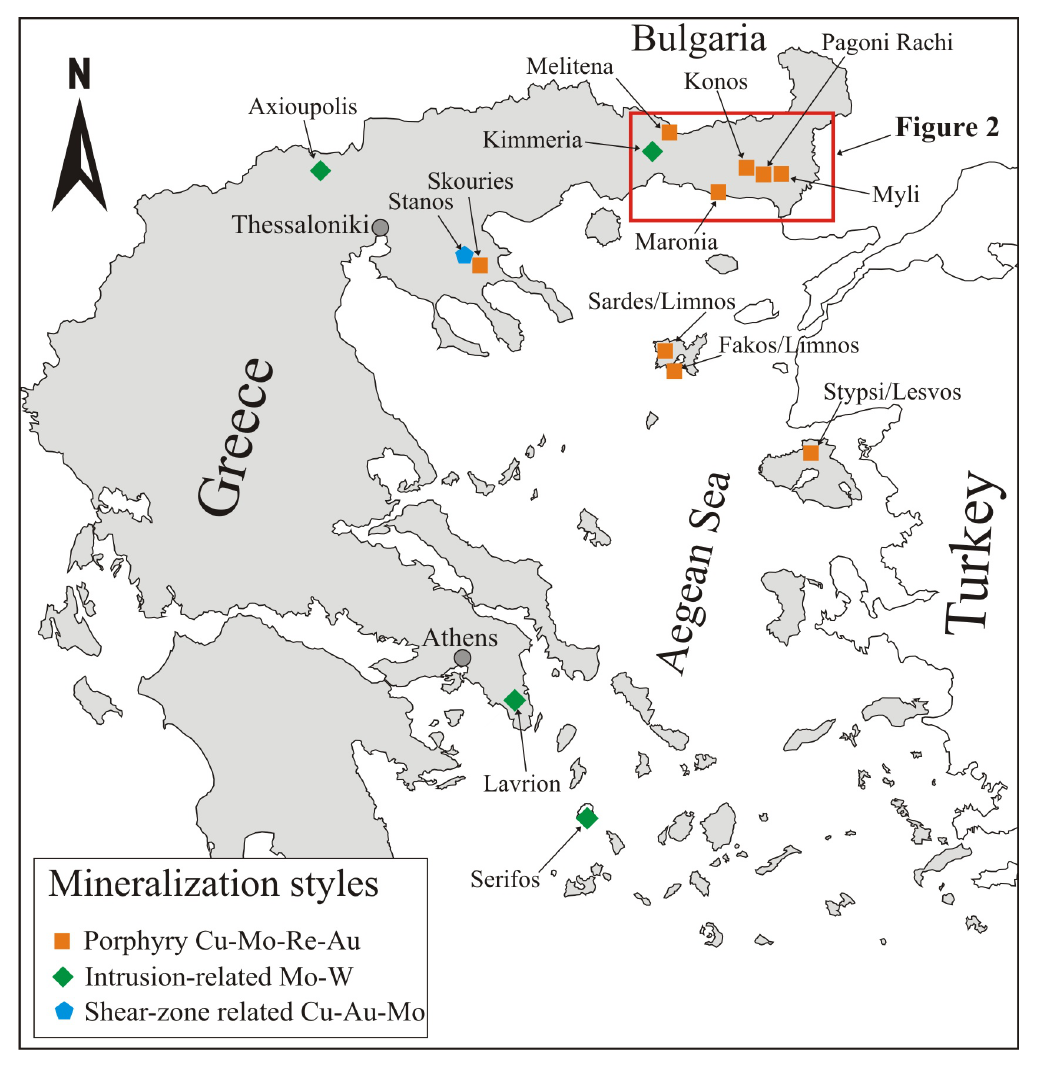
Figure 1. Location of molybdenite-bearing mineralization in Greece (modified after